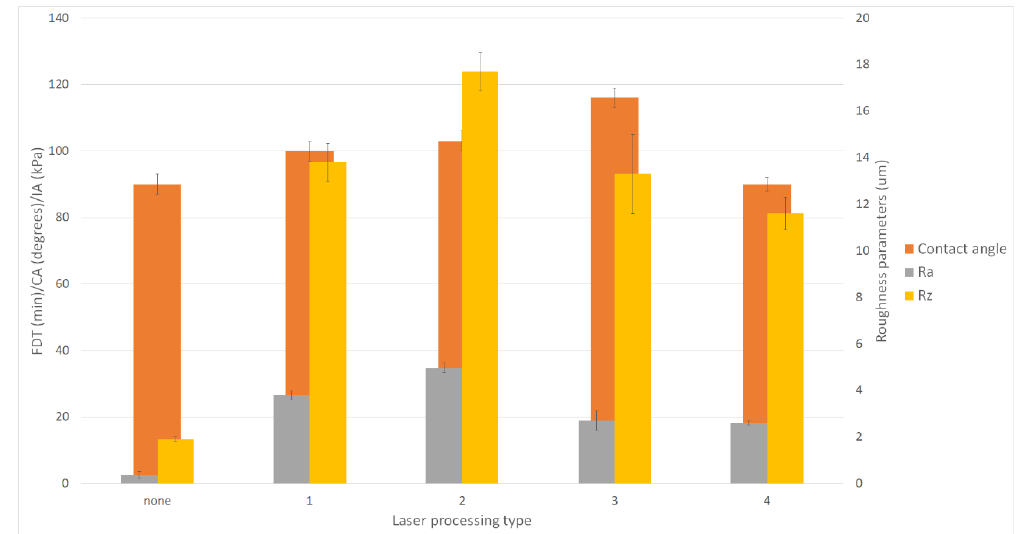
Figure 8. Characteristics of samples with no chemical modifier for different laser processing types.